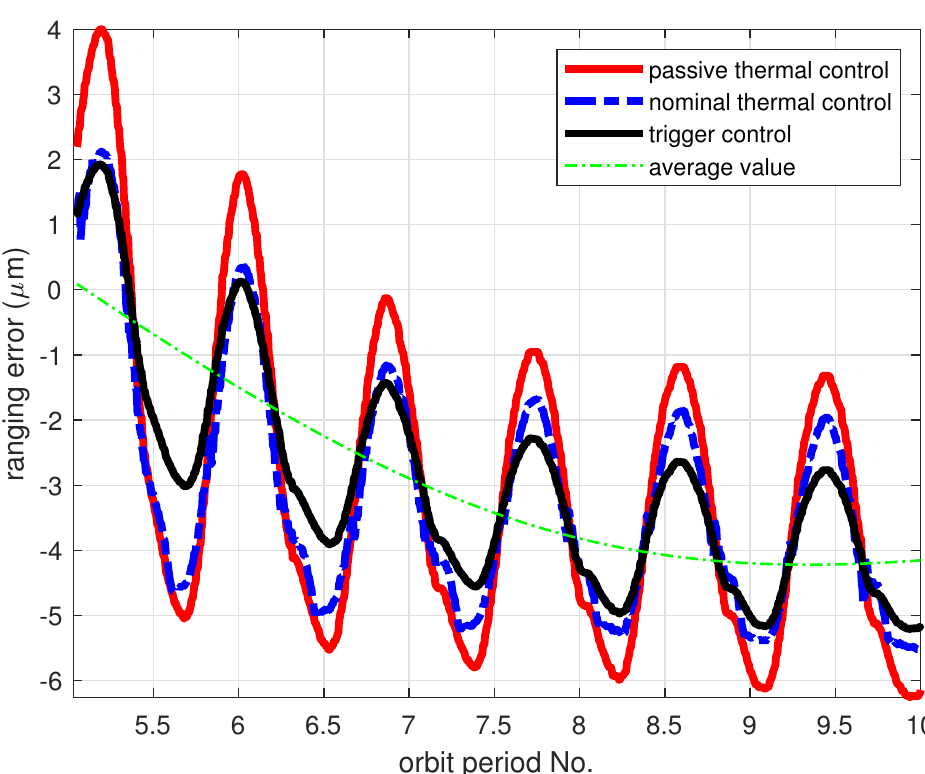
Figure 9. The micron level ranging error during different thermal control